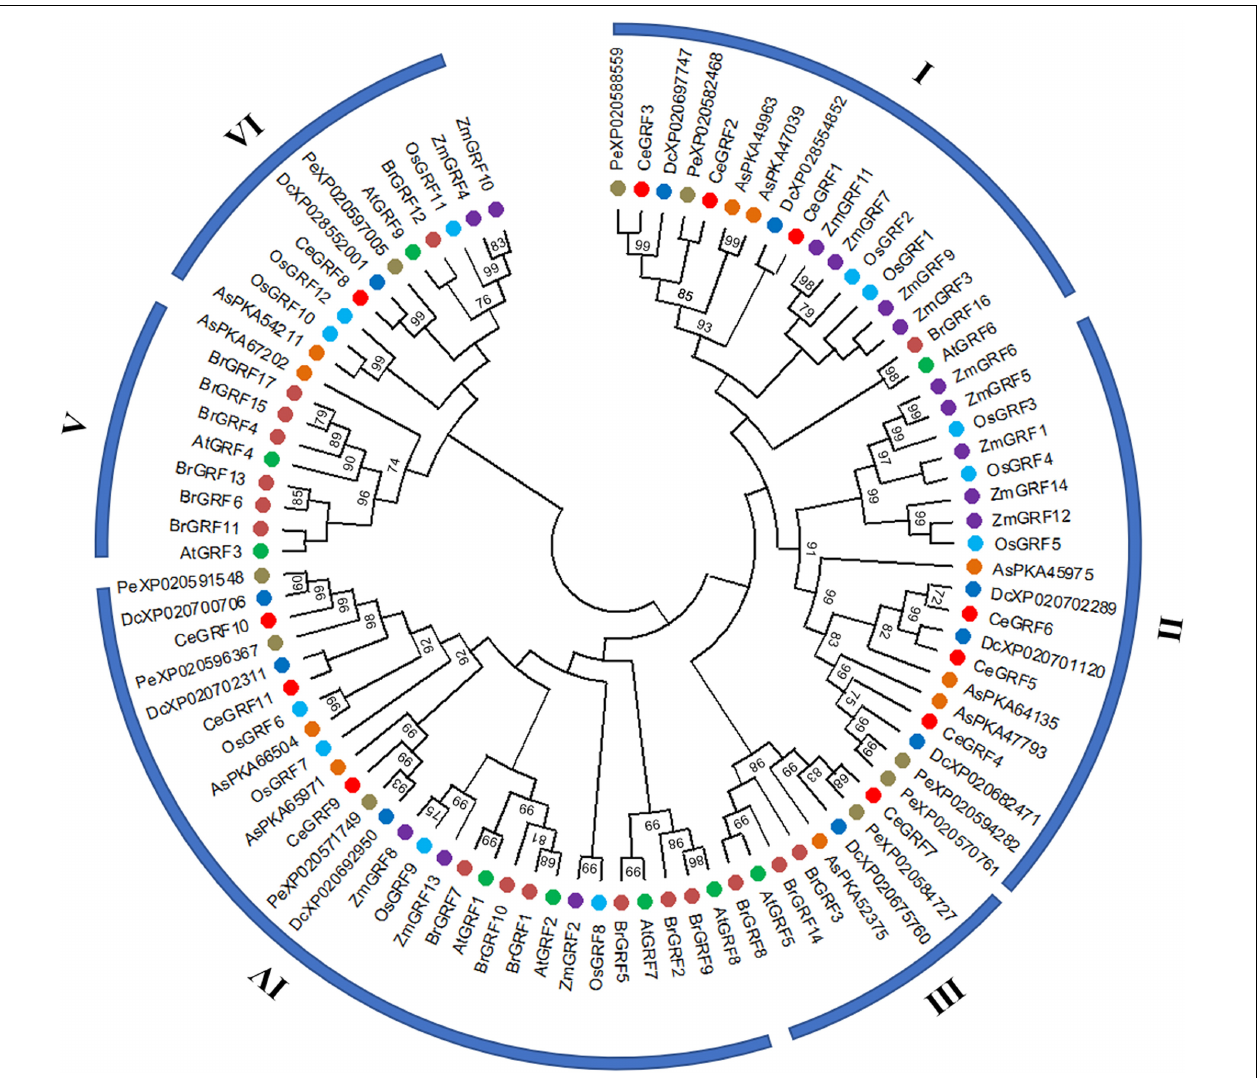
FIGURE 3 | Phylogenetic relationships among GRFs. Neighbor-joining phylogenetic tree was constructed by MEGAX.0 software with the Poisson model and 1,000 bootstrap computations. The GRF proteins were grouped into six distinct types, and represented GRFs from Arabidopsis thaliana (At), Oryza sativa ( Os ), Brassica rapa (Br), Zea mays (Zm), Dendrobium catenatum (Dc), Apostasia shenzhenica (As) and Phalaenopsis equestris (Pe). Each species is represented by a different